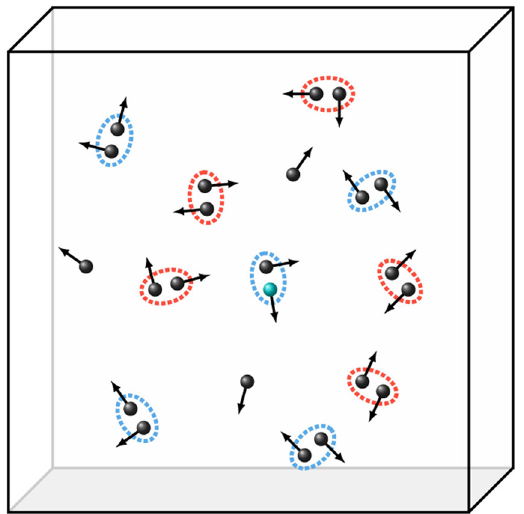
Fig. 2 A toy model analogous to a system with dynamics given by an approximate unitary design with two kinds of two-qubit interactions only. An impurity particle (teal) immersed in a gas of n E particles (arrows depicting direction of motion) within a closed box, where all particles interact in pairs in one of two ways (dashed circles) at random, can be similarly described by an approximate unitary design. The result of Theorem 1 ensures that for a large enough n E and number of interactions, most processes analogous to this one with approximate unitary designs will be almost